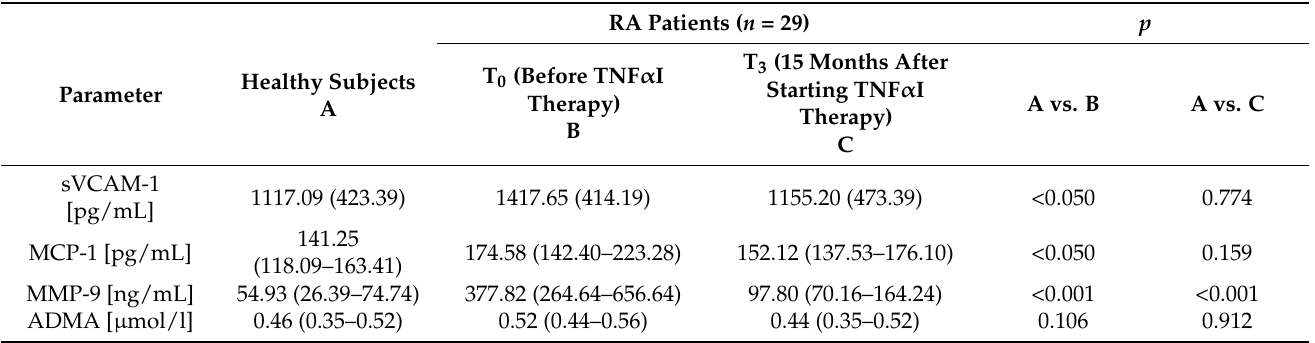
Table 3. Circulating levels of sVCAM-1, MCP-1, MMP-9 and ADMA in healthy subjects and